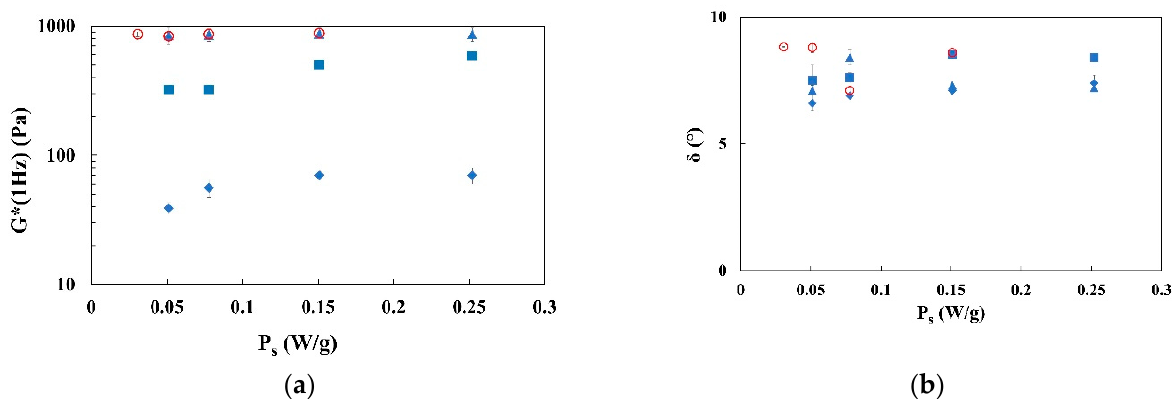
Figure 5. ( a ) Complex modulus G * (1 Hz) and ( b ) phase angle δ (1 Hz) of emulgels at different fiber concentrations for different specific powers of mixing (P s ) at the two energy levels E1 s = 22.6 J/g (open symbols) and E2 s = 45.2 J/g (solid symbols). E2.x.1.20: blue diamonds, E2.x.2.20: blue squares, E2.x.3.20: blue triangles, E1.x.3.20: red circles.